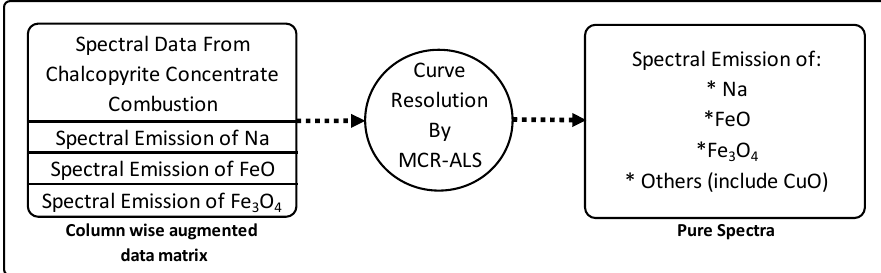
Figure 9. Data processing schemes using MCR-ALS.